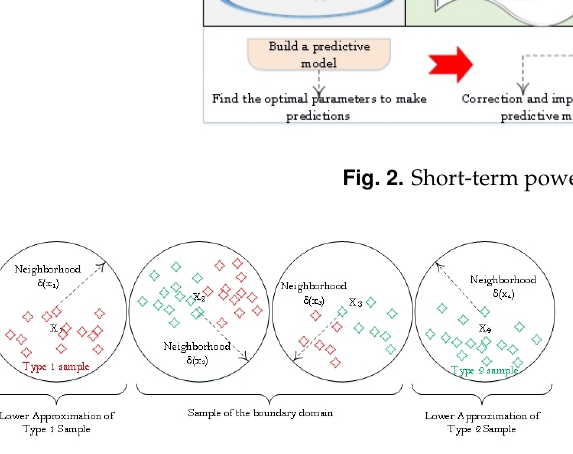
Fig. 3. Neighborhood rough set